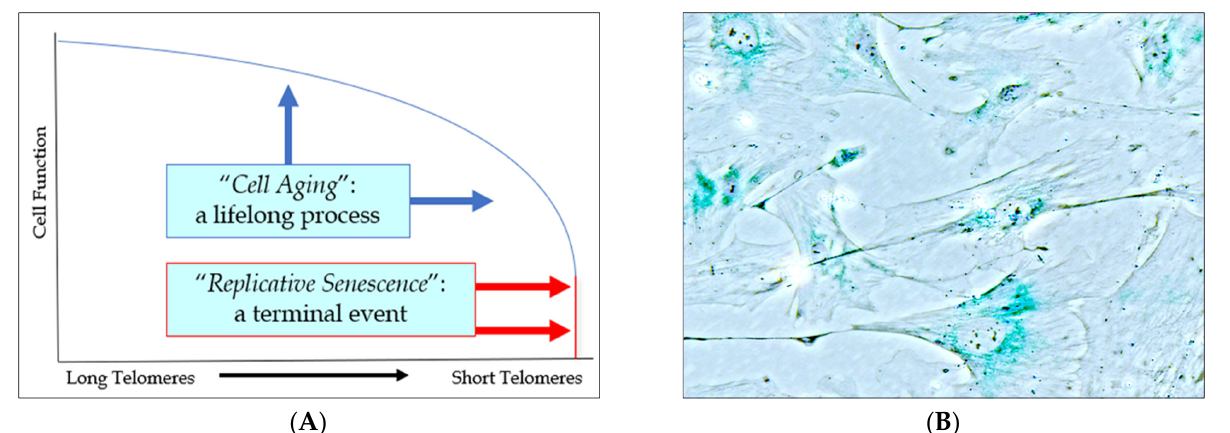
Figure 1. Cell aging and senescence. ( A ) Cell aging is a continuum characterized by a gradual decline in cell function, while cell senescence is the endpoint of this process. ( B ) Fibroblasts in culture undergoing senescence, as detected by blue SA-beta-galactosidase staining (courtesy of Zhanguo Gao).